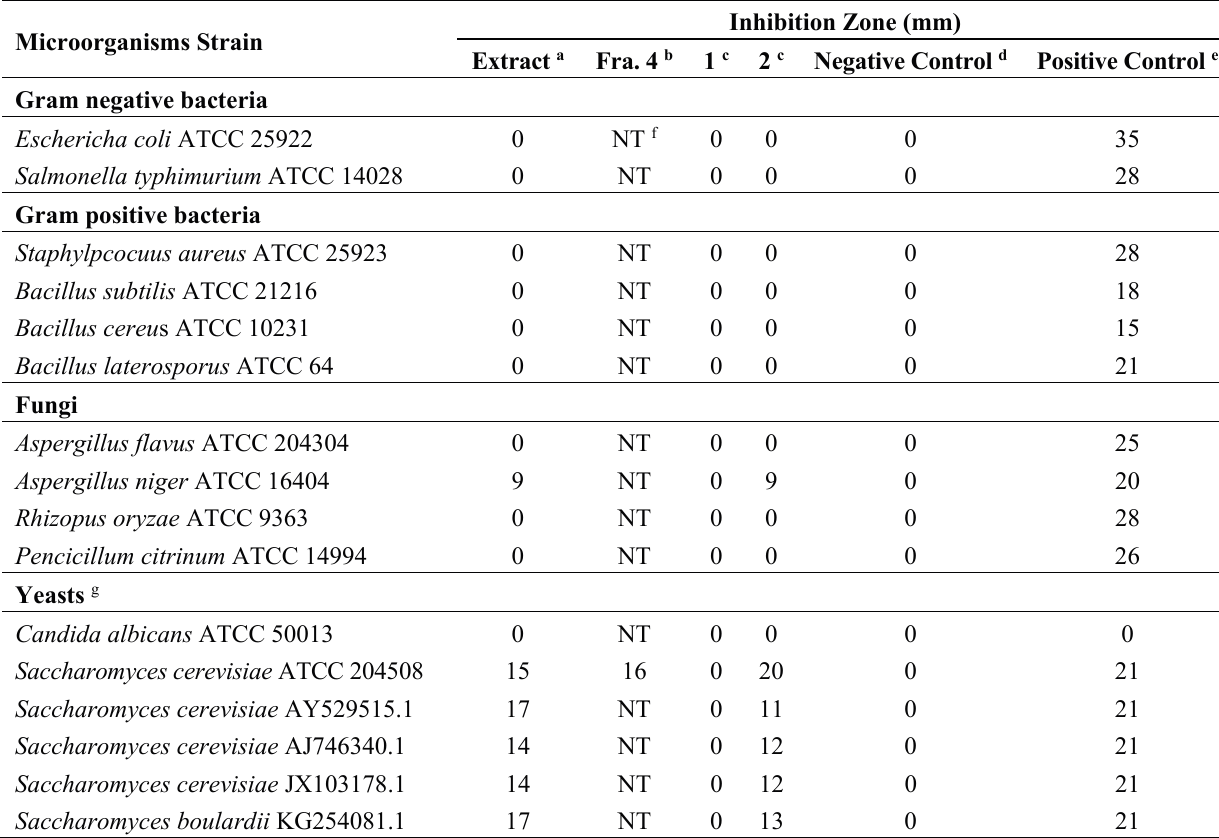
Table 2. Antimicrobial activity of U . lobata extract, Fra. 4, ( − )-trachelogenin ( 1 ) and clematoside-S ( 2